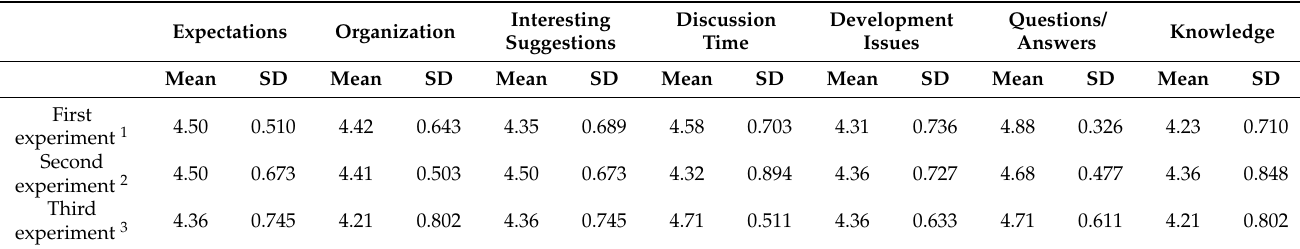
Table 6. Mean values and standard deviations of “acquired knowledge organization” questions in relation to the experiments (level of study/place of conduct of the interactive teaching) of budding journalists.